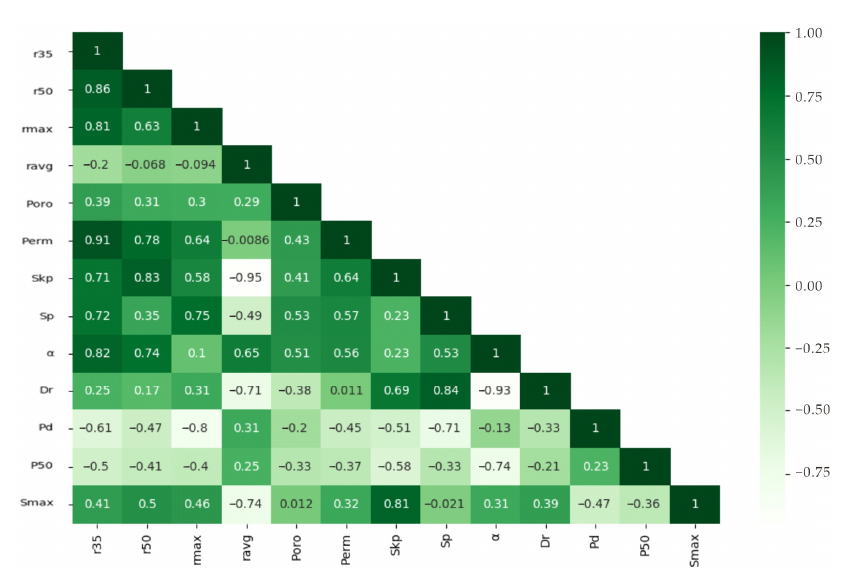
Figure 20. The correlation between R35 and other pore characteristic parameters.